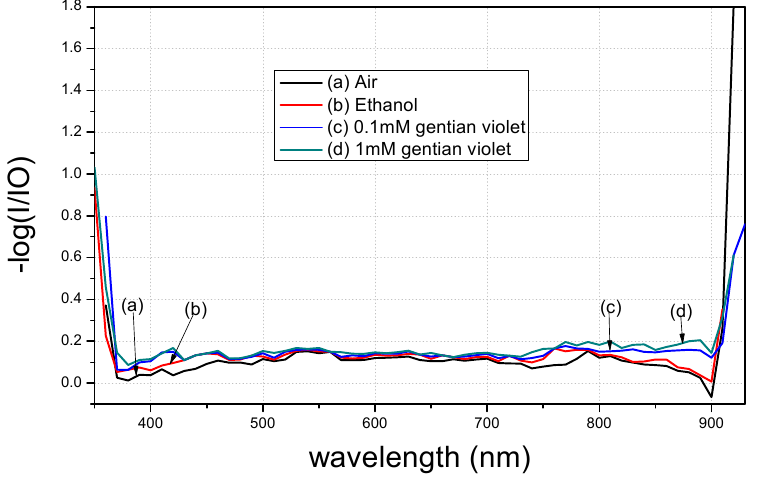
Figure 11. Transmittance of the modified fiber by APTMS after treatment with t -dodecylmercaptan.